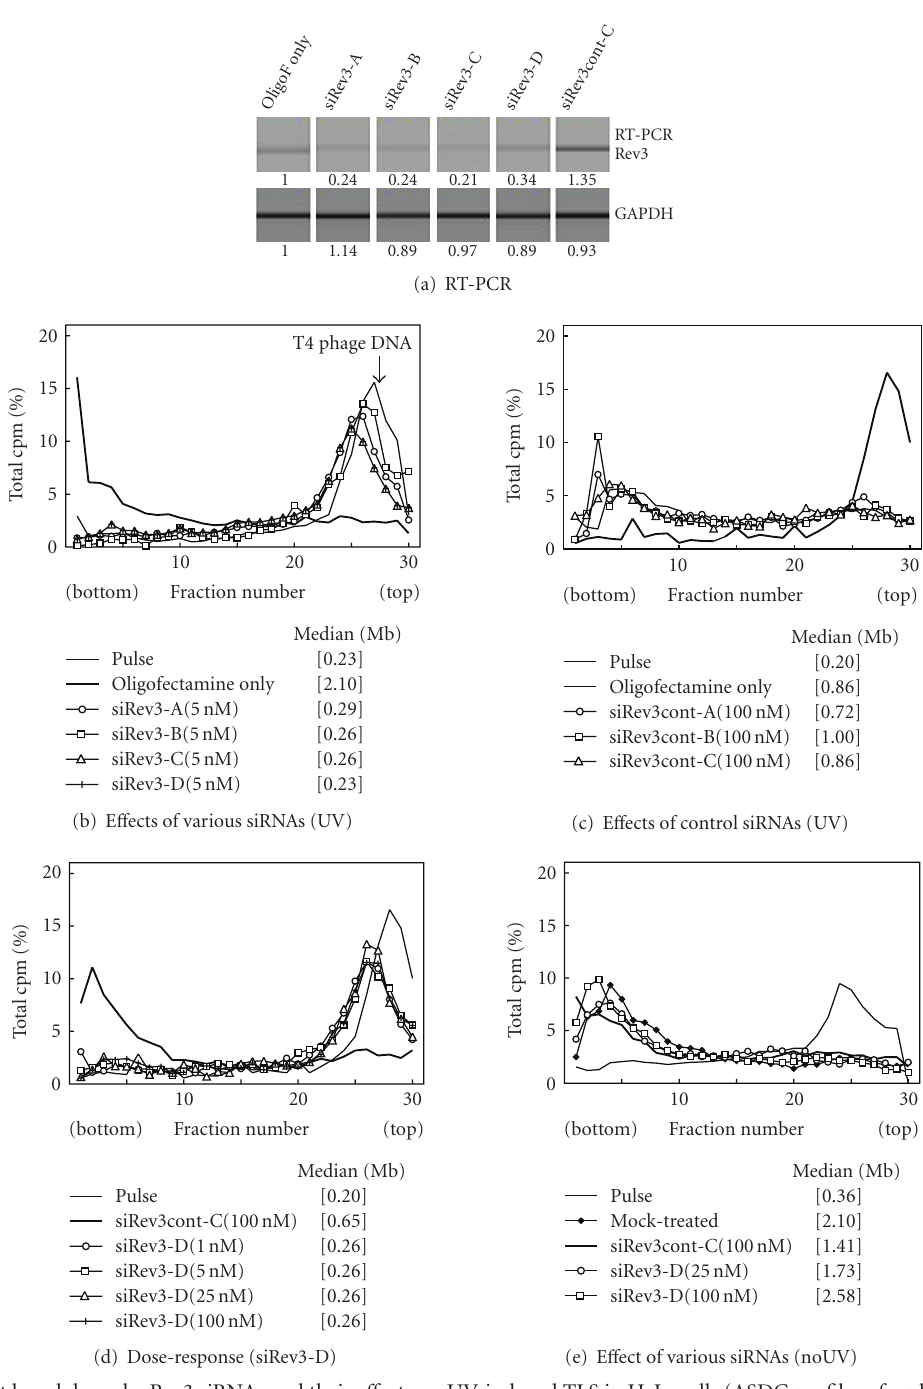
Figure 1: E ffi cient knockdown by Rev3 siRNAs and their e ff ects on UV-induced TLS in HeLa cells (ASDG profiles of replication products). (a) E ffi ciency of knockdown on Rev3 expression (RT-PCR analysis); (b) E ff ects of various Rev3 siRNAs; (c) E ff ects of Rev3 control